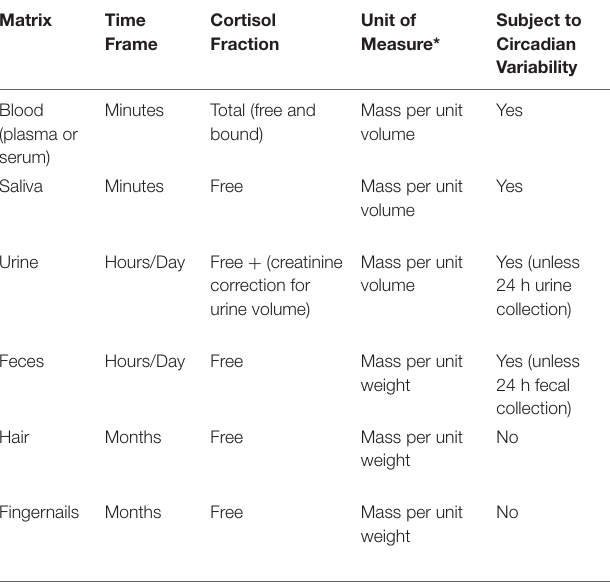
TABLE 1 | Characteristics of various cortisol sampling